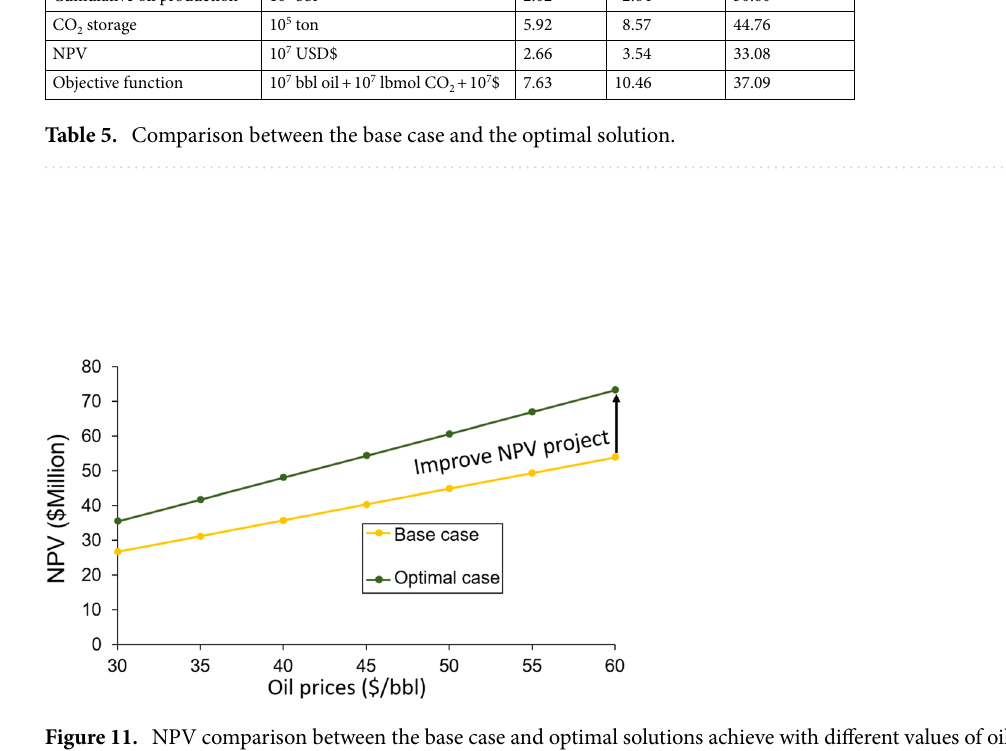
Figure 11. NPV comparison between the base case and optimal solutions achieve with different values of oil